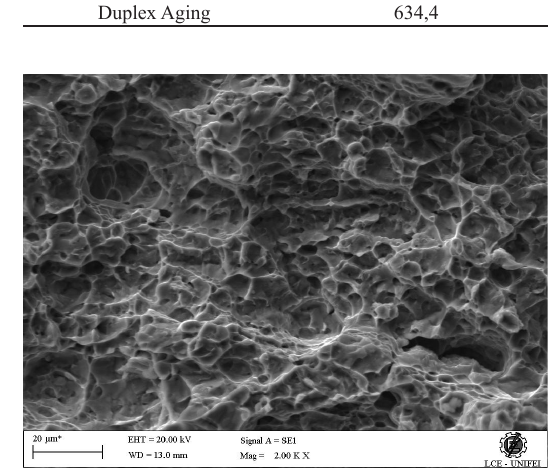
Figure 6. SA Sample: Dimples in Central Region.